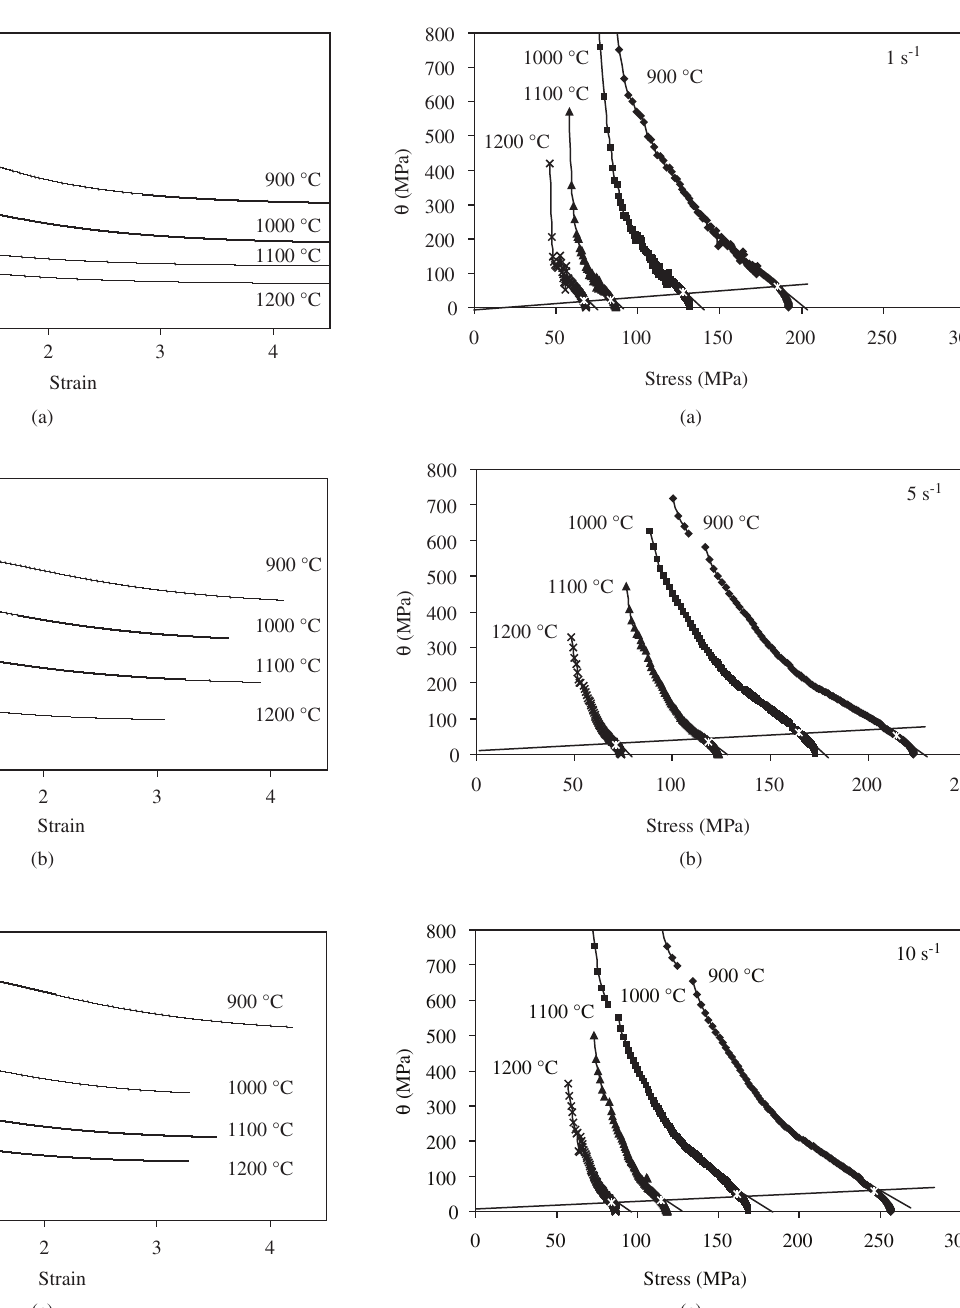
Figure 1. Isothermal flow stress curves determined with strain rates of a) 1 s -1 ; b) 5 s -1 ; and c) 10 s -1 .